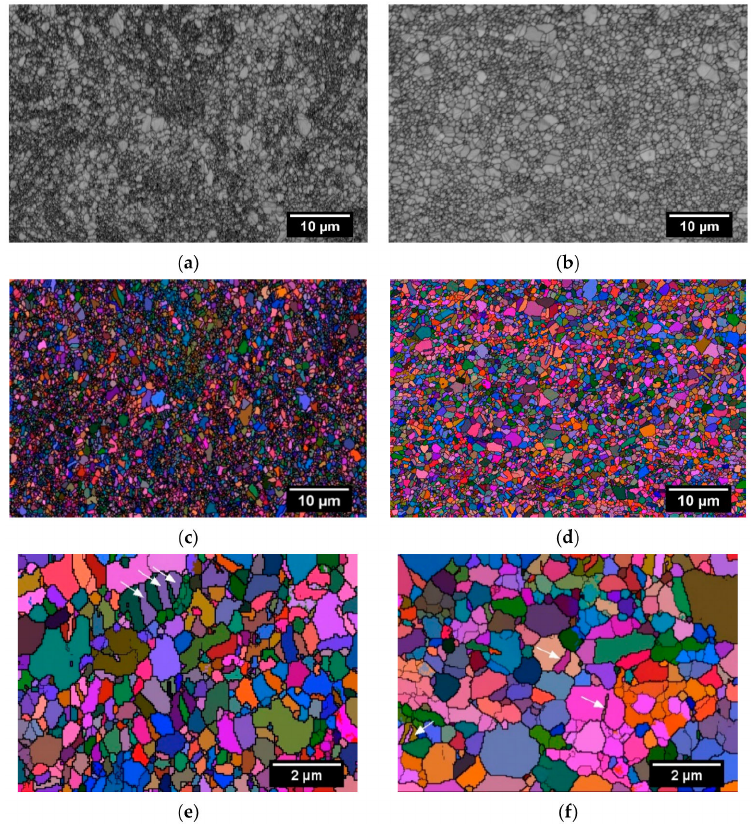
Figure 2. The microstructure of experimental materials from the EBSD analysis displayed in band contrast ( a , b ) and Euler’s colours ( c–f ), twins in the microstructure are marked by